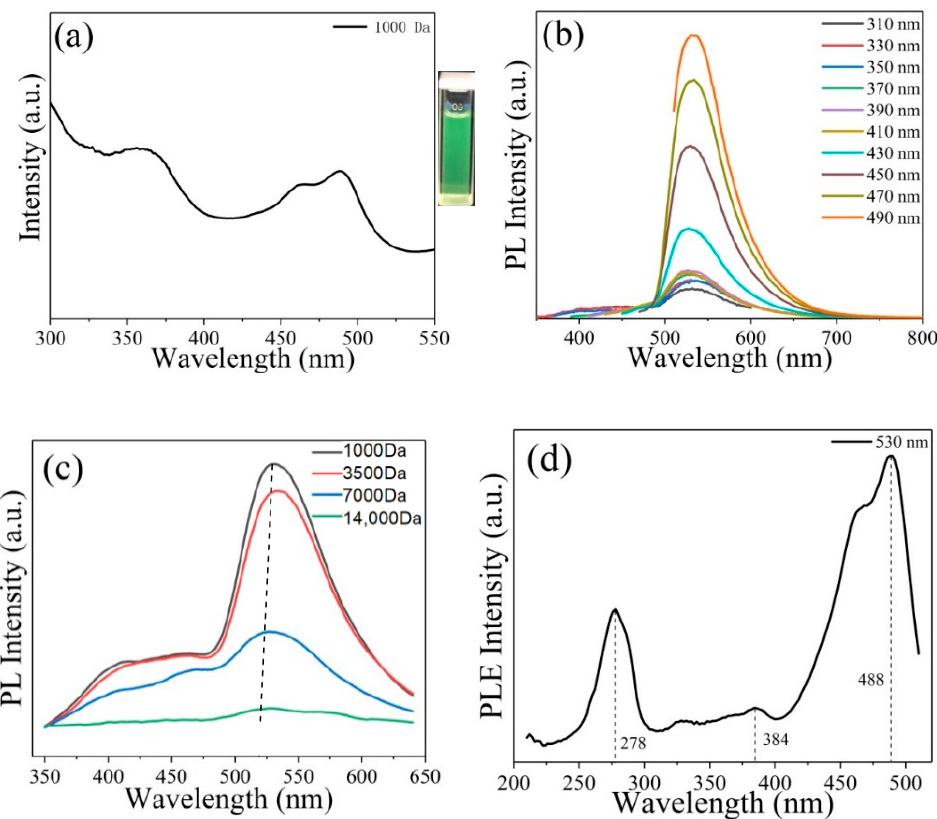
Figure 5. ( a ) UV–VIS absorption spectrum of the GQDs dialyzed with a dialysis bag of 1000 Da molecular weight (inset, optical photographs of the corresponding samples under excitation with a wavelength of 365 nm), ( b ) PL spectra of the GQDs under excitation with a different wavelength, ( c ) PL spectra of the four separated GQDs under excitation at 330 nm, ( d ) PLE spectrum of the GQDs when fixing the emission wavelength at 530 nm.